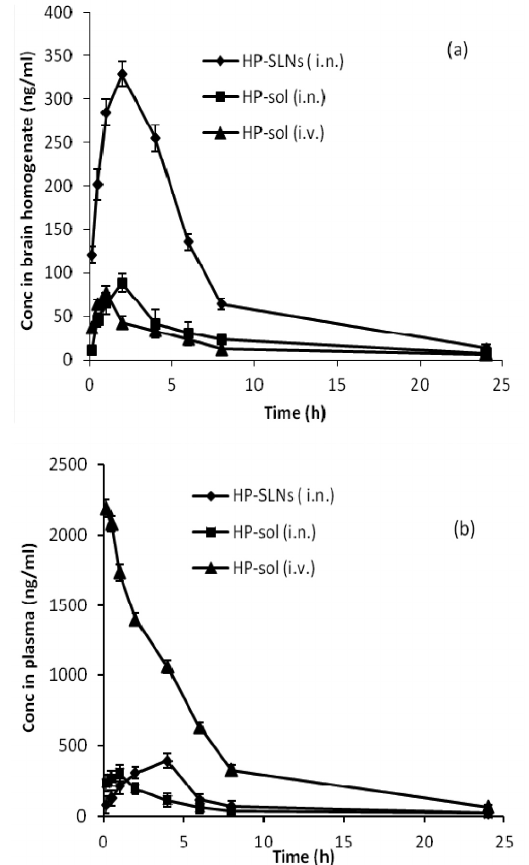
FIGURE 7 - Haloperidol concentration in (a) rat brain (b) rat plasma at different time intervals following HP-SLNs